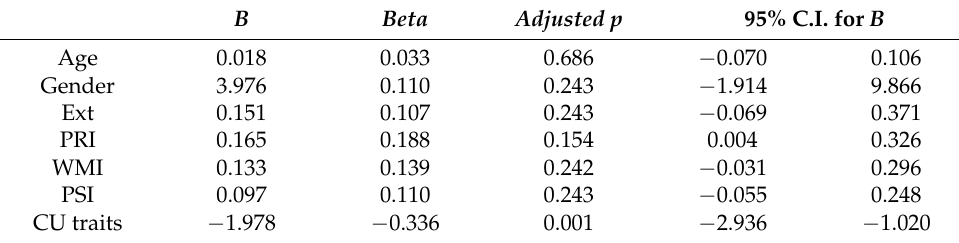
Table 2. Linear regression models with CU traits and covariates predicting